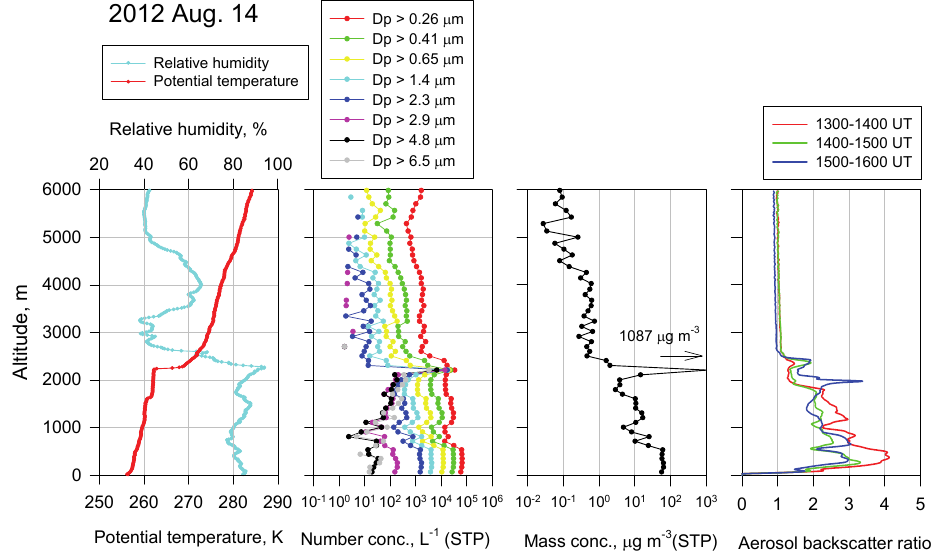
Fig. 2. Vertical variations of potential temperature, relative humidity, aerosol number concentration, mass concentration, and backscatter ratio over Syowa Station on 14 August 2012. Vertical blue line represents the time of aerosol sonde